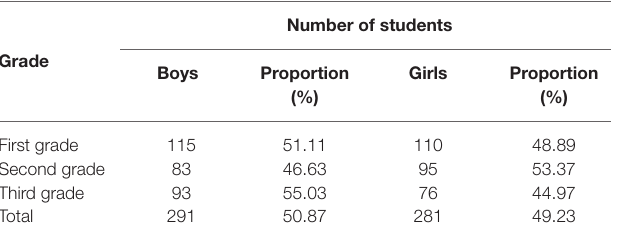
TABLE 1 | Distribution of participating